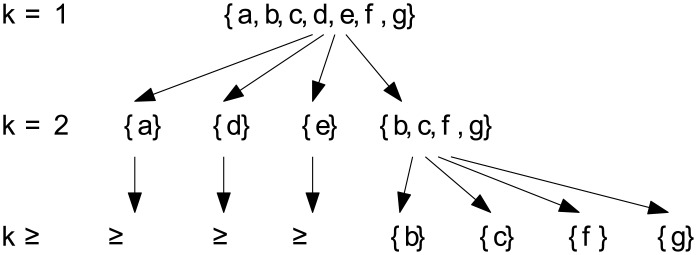
The components for all k derived from the graph in Fig 2.